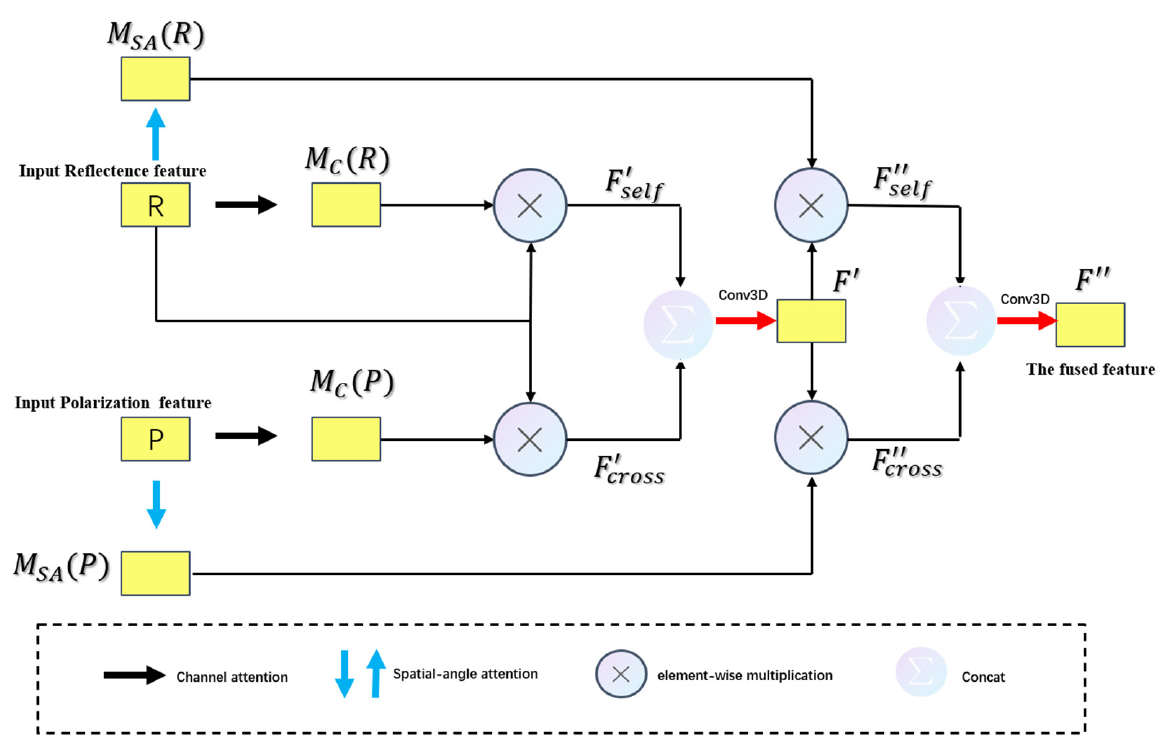
Figure 7. Detailed structure of CA module. Channel attention module M C and spatial-angle attention module M SA are two im- portant parts of the CA module, which generate attention weight in channel dimension and spatial-angle dimension, respectively. Figures 8 and 9 depict the computation process of each attention map. The following describes the details of each attention